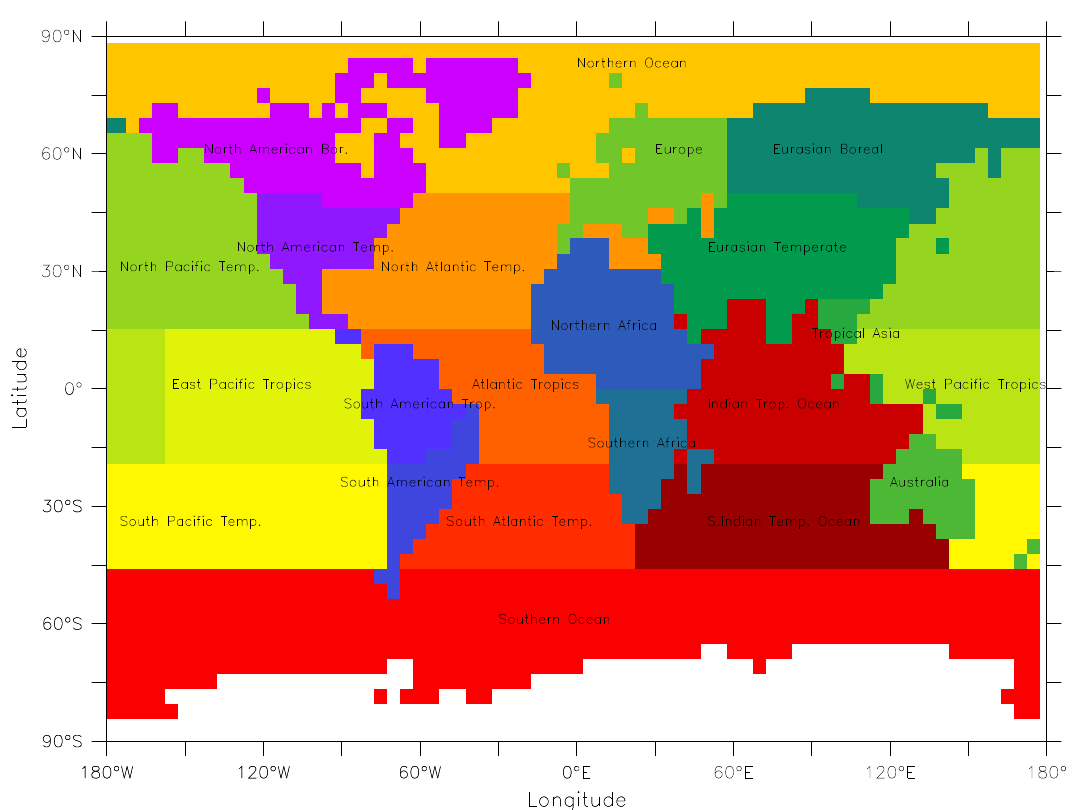
Fig. 1. Map of the land regions used for the regional benchmark of phenology and the analysis of the biosphere fluxes, as defined in the